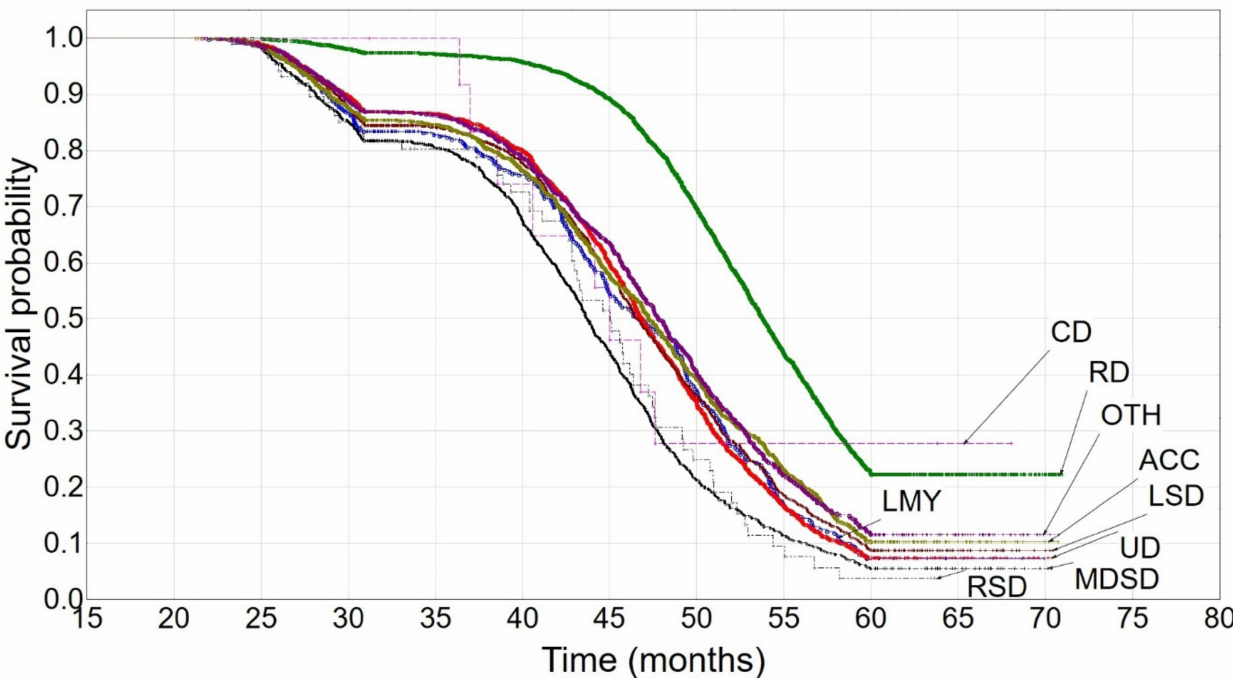
Figure 2. The Kaplan–Meier survival probability until the second lactation. UD—udder diseases, RD—reproductive disorders, CD—contagious diseases, MDSD—metabolic and digestive system diseases, RSD—respiratory system diseases, LSD—locomotor system diseases, ACC—accidents, OTH—others, LMY—low milk